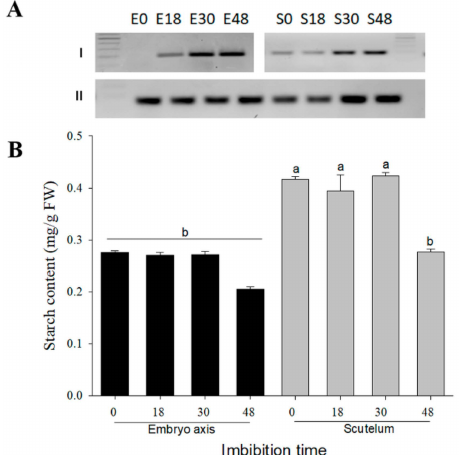
Figure 6. mRNA profile of α -amylase ( A ) and starch content ( B ). (A) Transcripts of I: α -amylase and II: 18s in embryo axis (E) and scutellum (S). (B) Starch content per gram of fresh tissue according to imbibition time. Bars show the average from two independent experiments with triplicates ± SD. Di ff erent letters indicate statistically significant values according to the Tukey test, p <